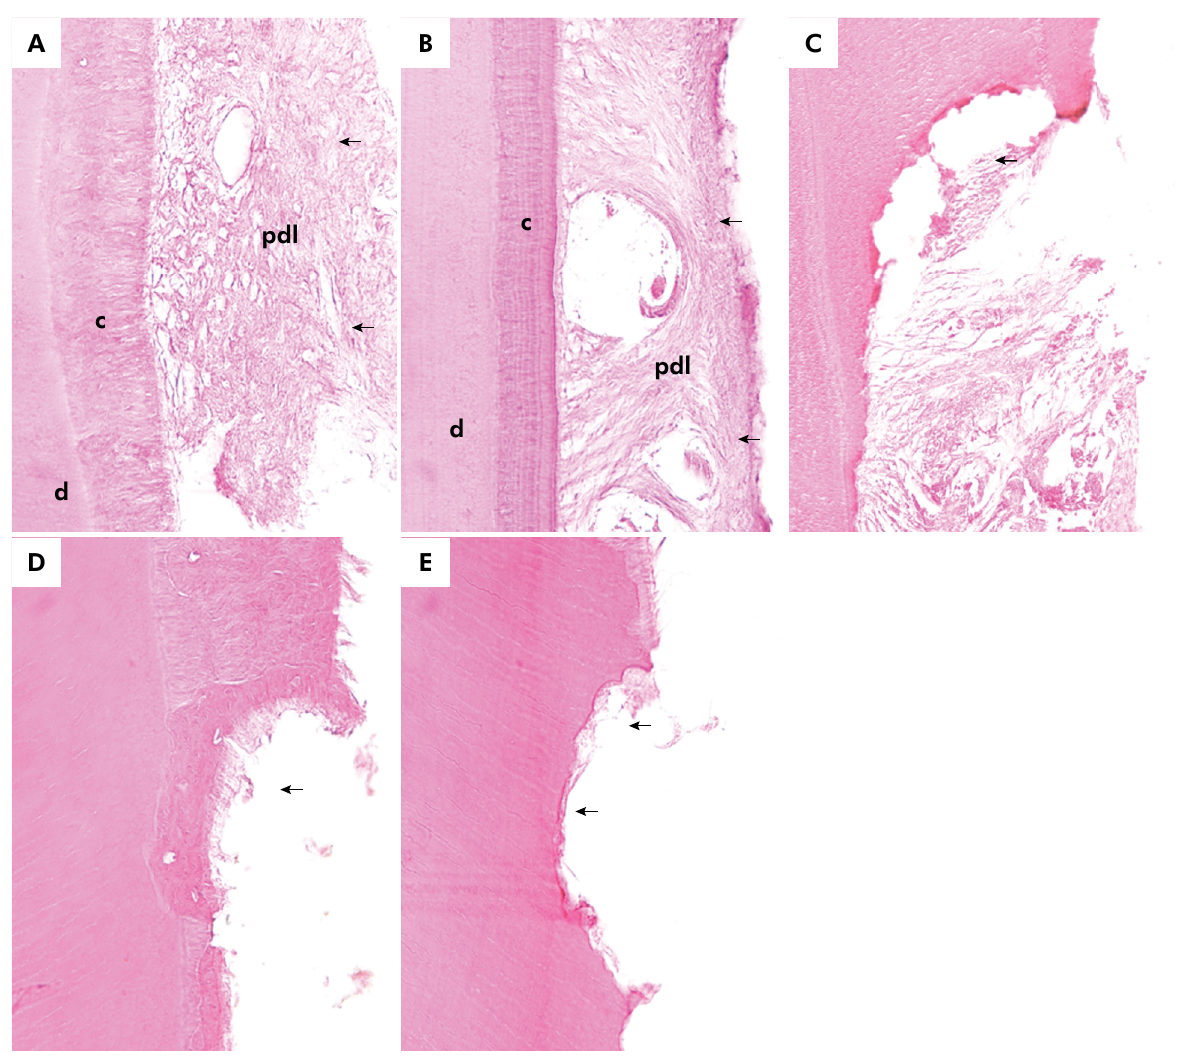
Figure 2. Photomicrography of PDL of human deciduous and permanent teeth; (A) PDL of deciduous molar with physiologic root resorption (magnification: 40x); (B) PDL of deciduous molar with inflammatory pathologic root resorption (magnification: 40x); (C) PDL of permanent molar (magnification: 40x); (D) Howship lacuna on root surface of deciduous molar with physiologic root resorption associated to organised PDL (magnification: 20x); (E) Howship lacuna on root surface of deciduous molar with physiologic root resorption associated to PDL with signs of repair (magnification: 40x); (F) Howship lacuna on root surface of deciduous molar with inflammatory pathologic root resorption, completely disorganised or with absent periodontal tissue (magnification: 20x); d: dentine; c: cementum; pdl: periodontal ligament; HE